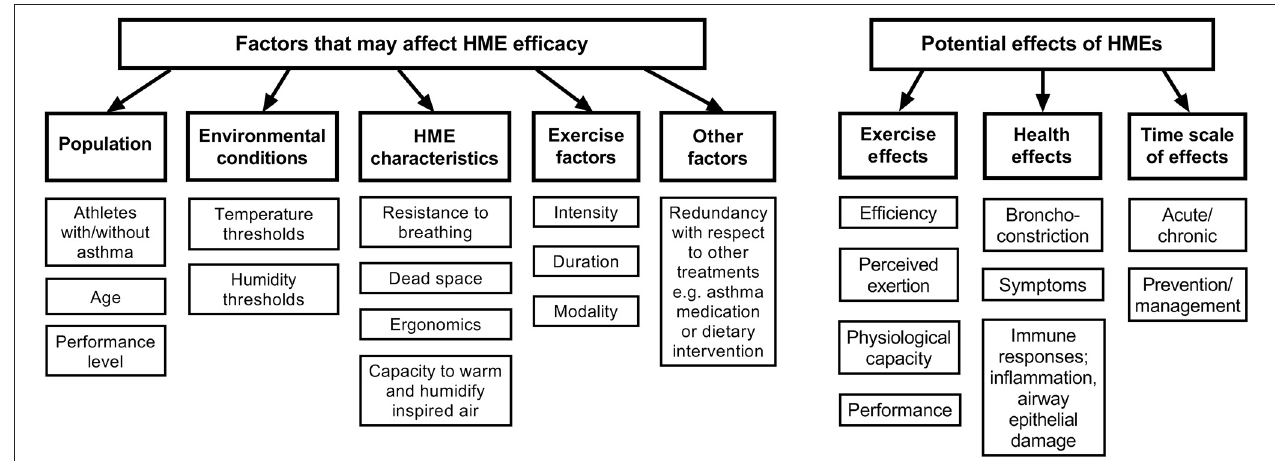
FIGURE 3 | Conceptual model of potential effects and interactions of HME use by athletes and exercising populations.